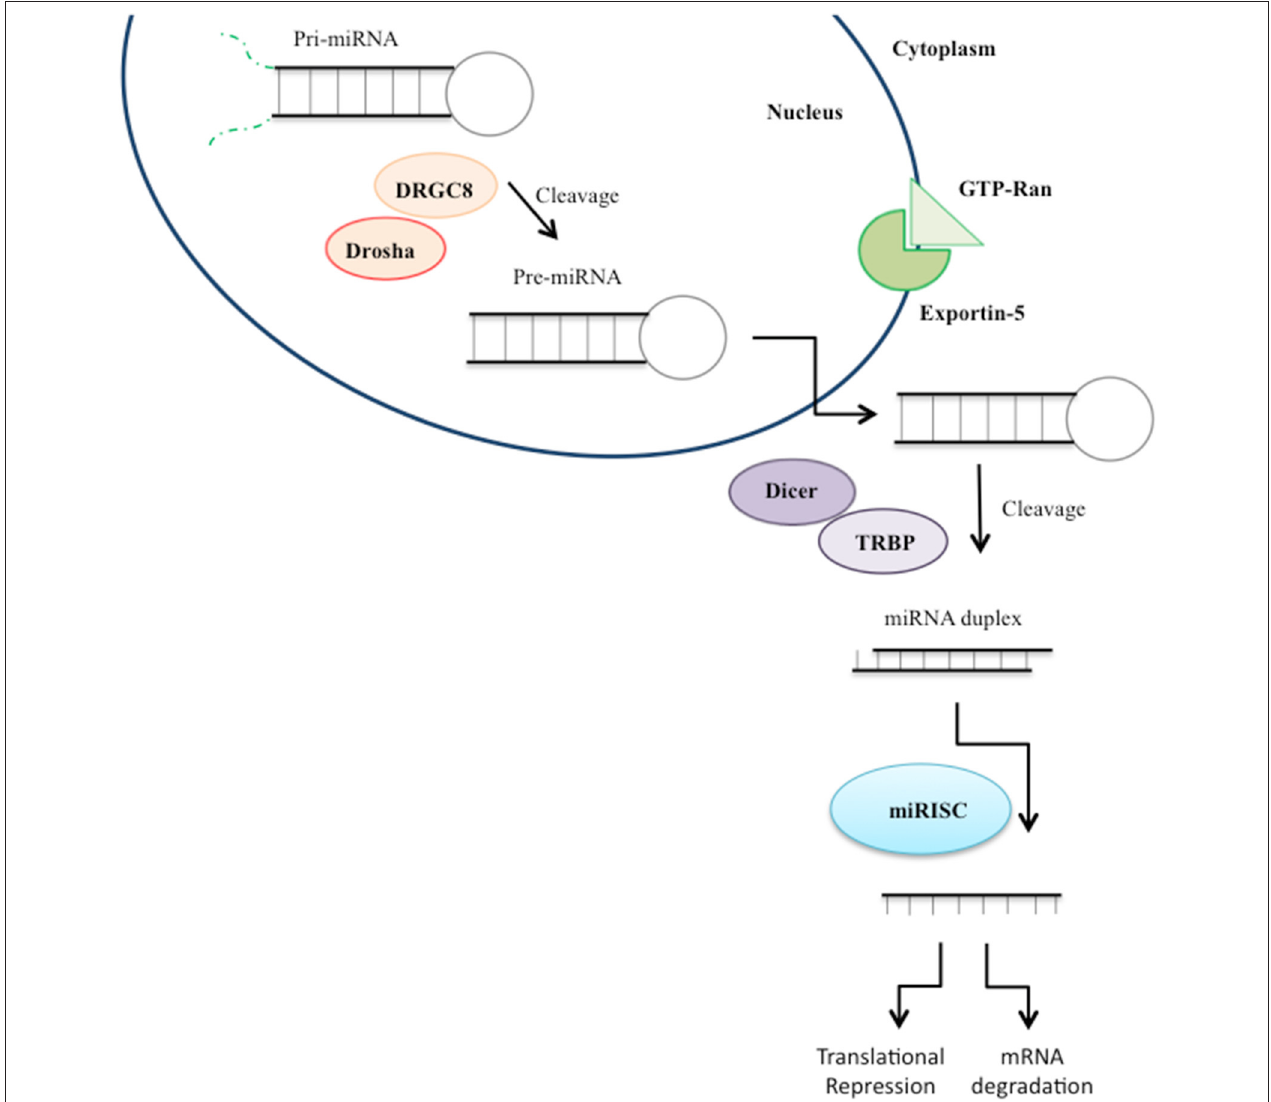
FIGURE 3 | miRNA biogenesis. MicroRNA (miRNA) genes are transcribed as primary miRNAs (pri-miRNAs) by RNA polymerase II (Pol II) in the nucleus. The long pri-miRNAs are cleaved by Microprocessor, which includes DROSHA and DiGeorge syndrome critical region 8 (DGCR8), to produce precursor miRNAs (pre-miRNAs), which are then exported to the cytoplasm by Exportin 5 and further processed by the DICER/TRPB complex to produce an miRNA duplex. One strand of the mature miRNA (the guide strand) is loaded into the miRNA-induced silencing complex (RISC) mediating gene suppression by targeted mRNA degradation or translational